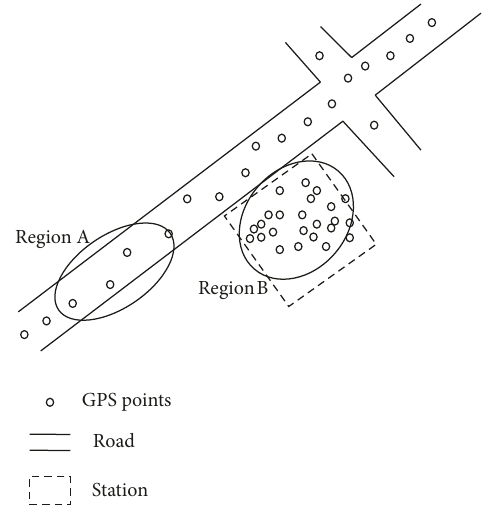
Figure 3: Spatial distribution characteristics of trajectory data under different